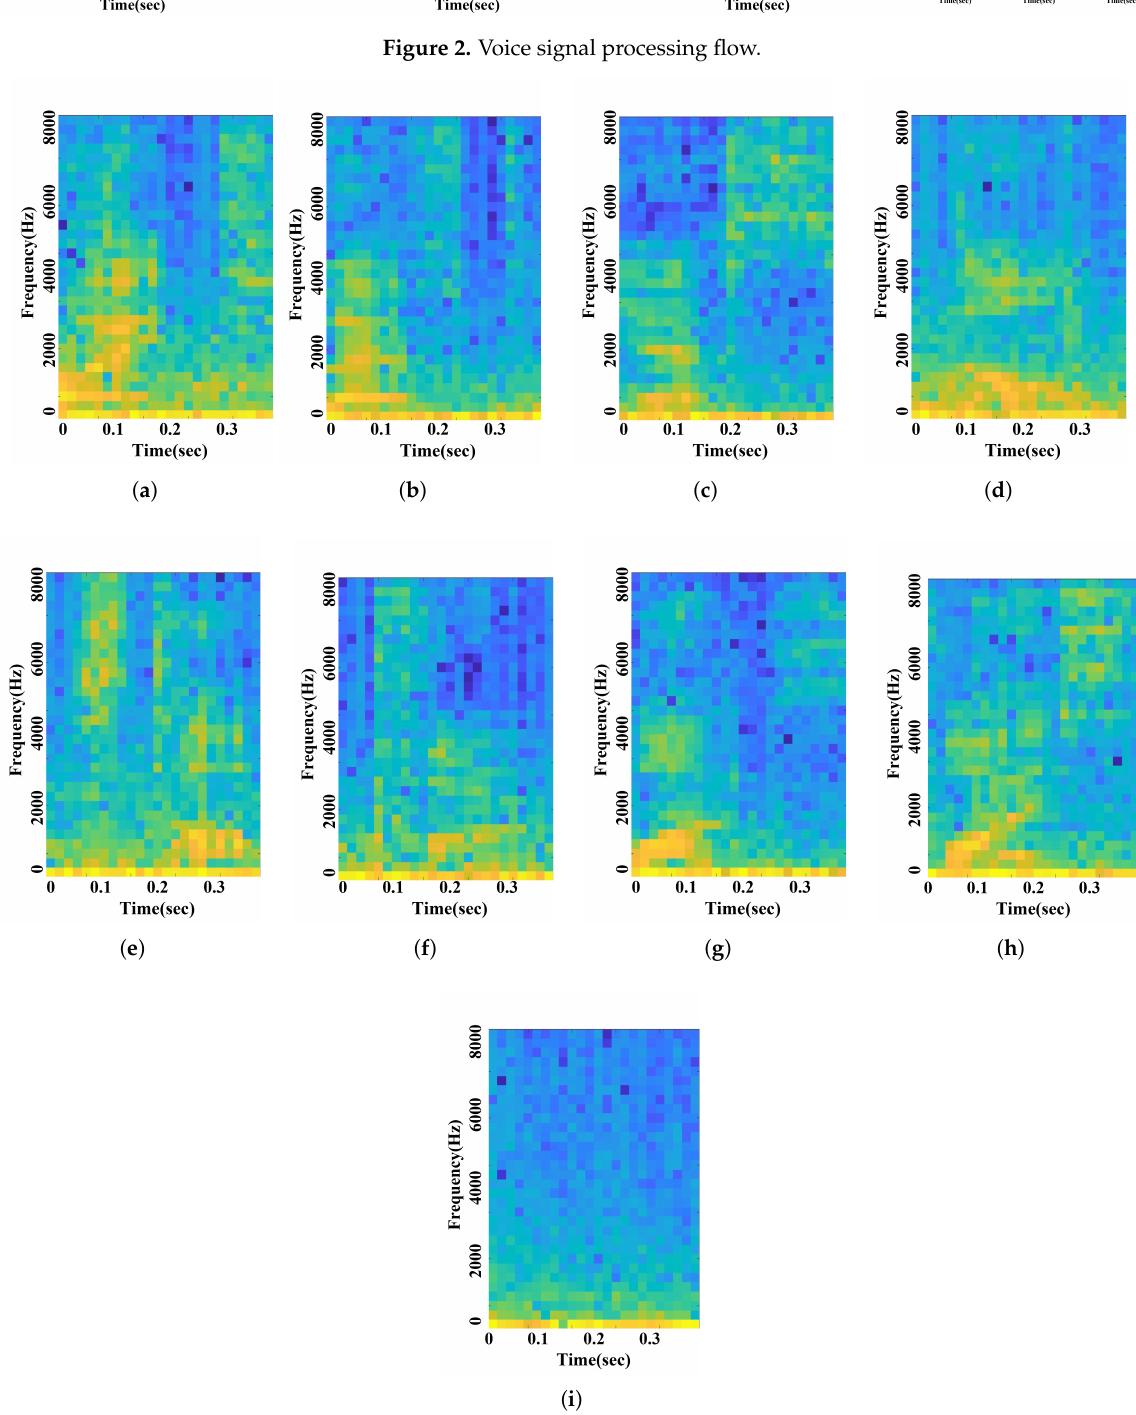
Figure 3. Voice spectrogram: ( a ) right; ( b ) left; ( c ) yes; ( d ) no; ( e ) stop; ( f ) pull; ( g ) once; ( h ) twice; ( i )